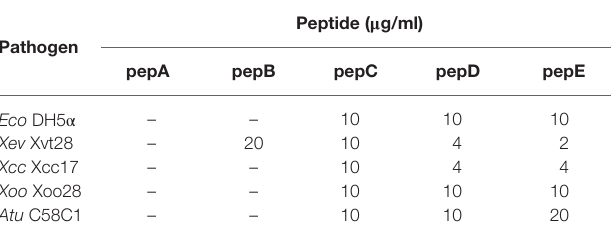
TABLE 2 | IC 50 values of pepA, pepB, pepC, pepD, and pepE against E. coli and phytopathogenic